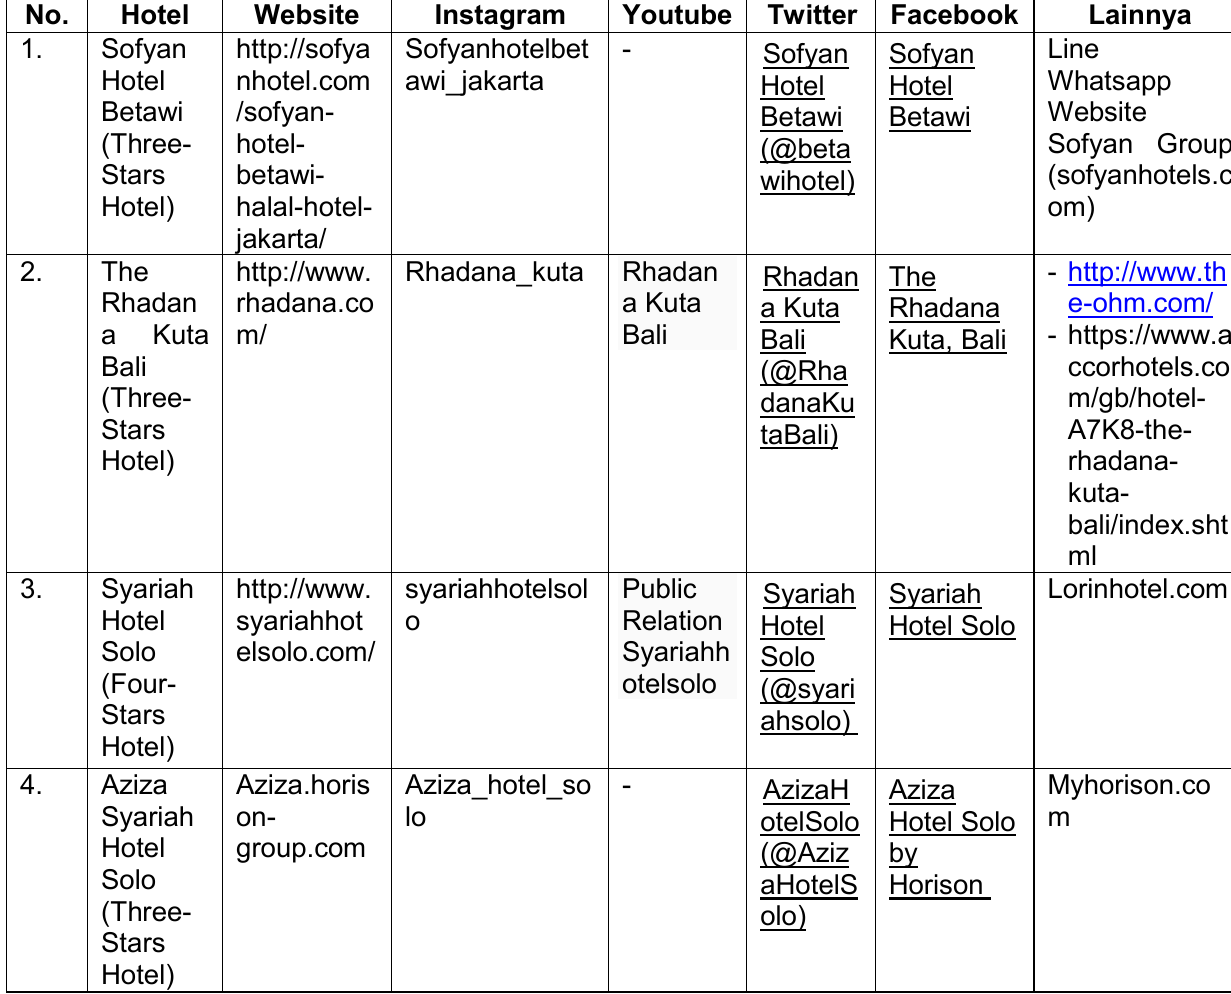
Table 1. Online Media of Sharia Hotels in